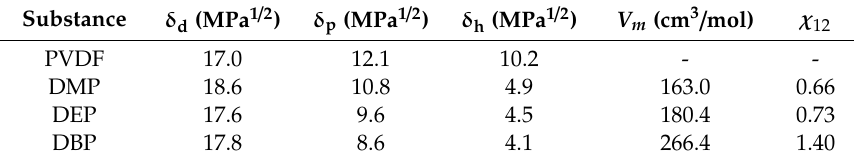
Table 2. Hansen solubility parameters of PVDF and dialkyl phthalate and their interaction parameters.